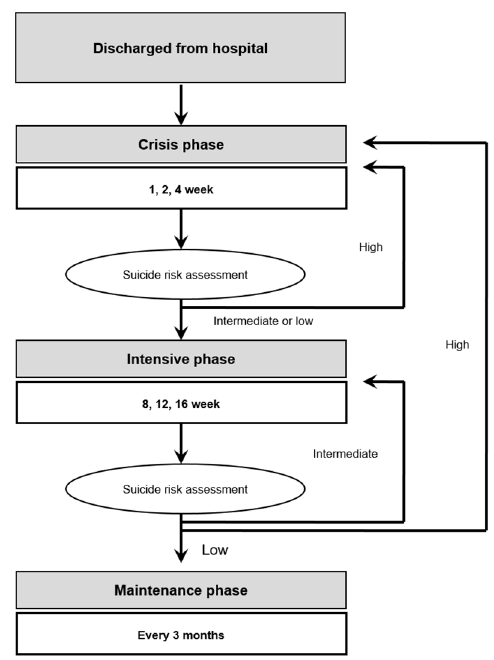
Figure 2. Protocol of the case management program.